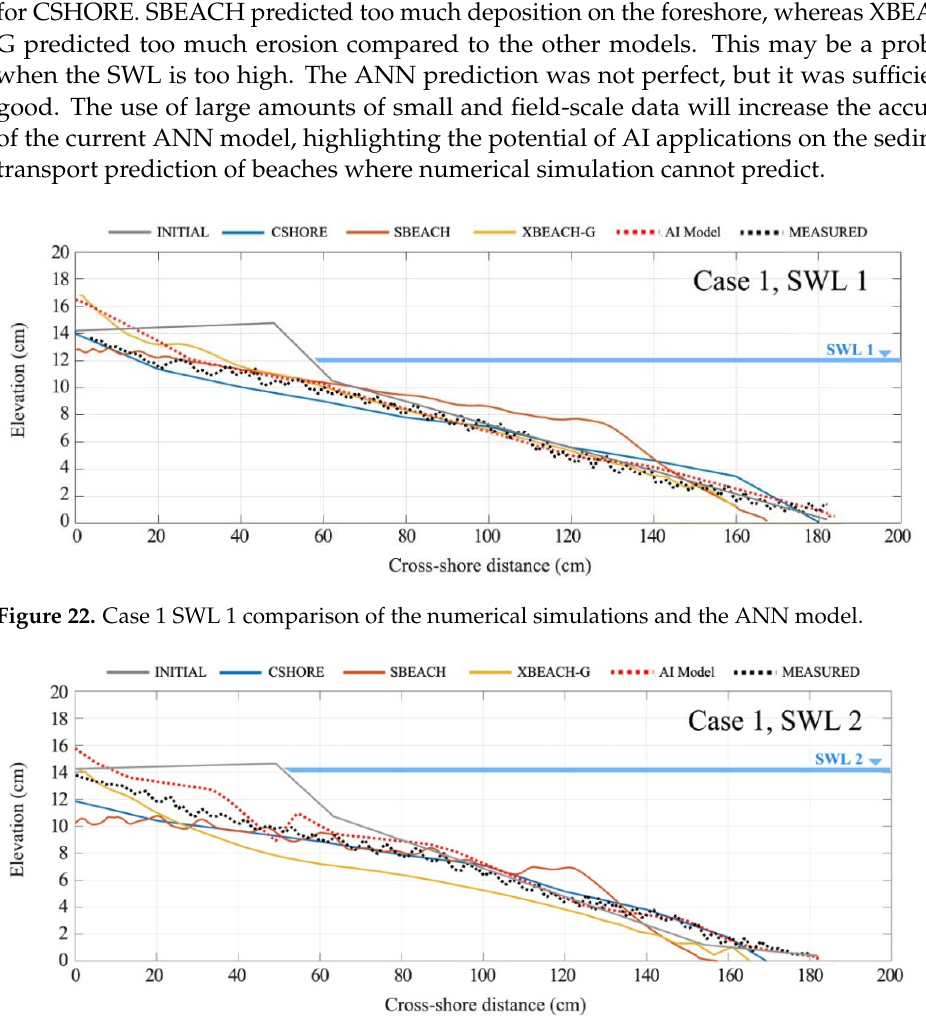
Figure 23. Case 1 SWL 2 comparison of the numerical simulations and the ANN model.